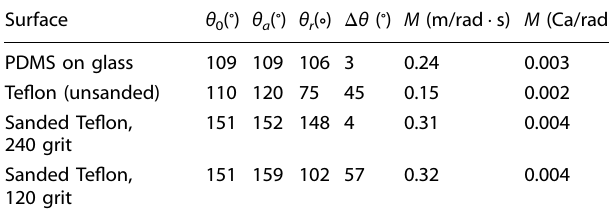
Table 2. Wetting properties of experimental surfaces de fi ned by